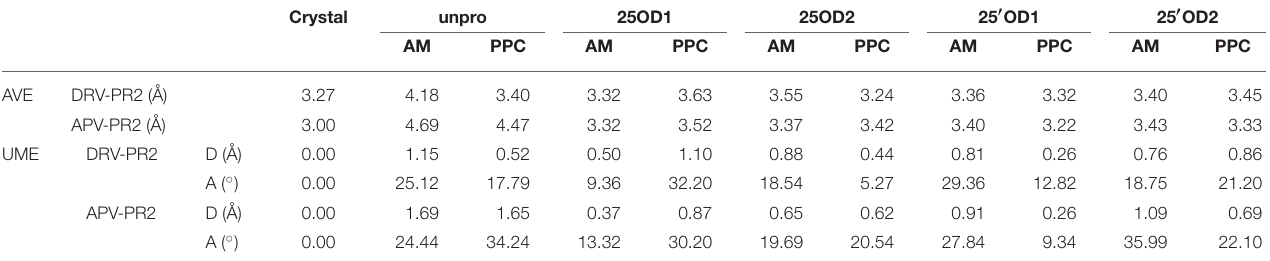
TABLE 1 | Average values and unsigned mean errors of geometric parameters of the protonated region during MD simulation. Crystal unpro 25OD1 25OD2 25 ′ OD1 25 ′ OD2 AM PPC AM PPC AM PPC AM PPC AM PPC